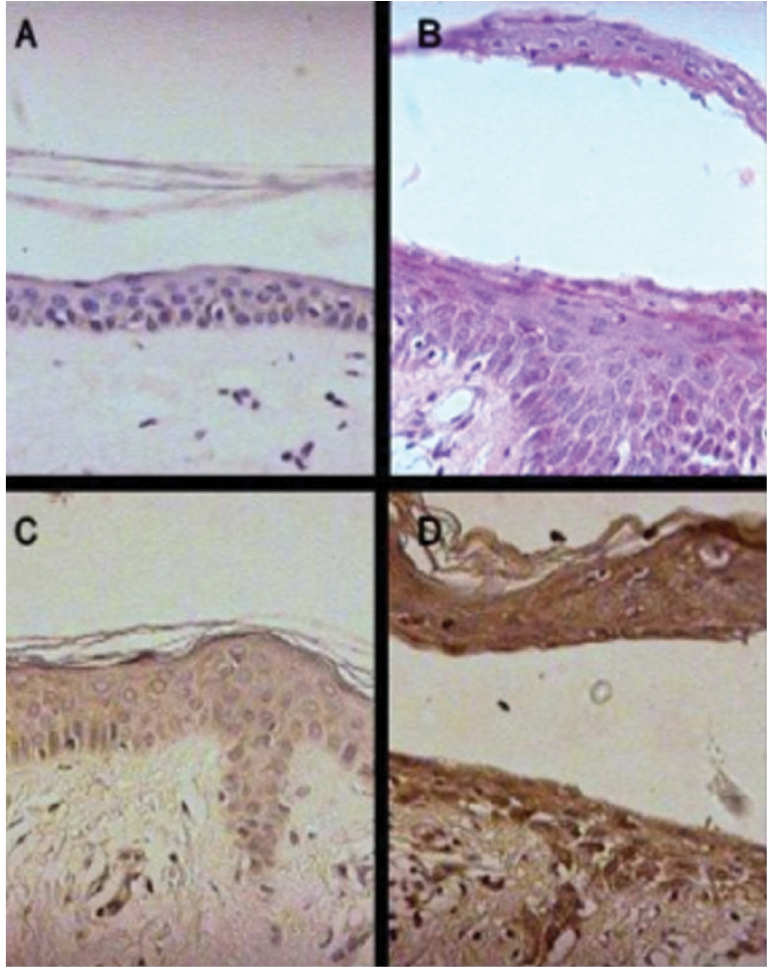
Figure 2. Representative light micrographs of immunohistochemistry for the detection of iNOS in a skin biopsy from healthy controls and pemphigus patients. All pemphigus skin specimens displayed similar staining. Figure 2A and B illustrates skin biopsies stained with hematoxylin-eosin of a healthy control (A) and a pemphigus patient (B). Figure 2C and D illustrates the immunohistochemistry of skin samples obtained from a healthy person (C) and a pemphigus patient (D) showing intense and diffuse iNOS immunostaining in the latter, that was particularly evident in the epidermal layers, as compared to the appearance of the healthy skin (original magnification